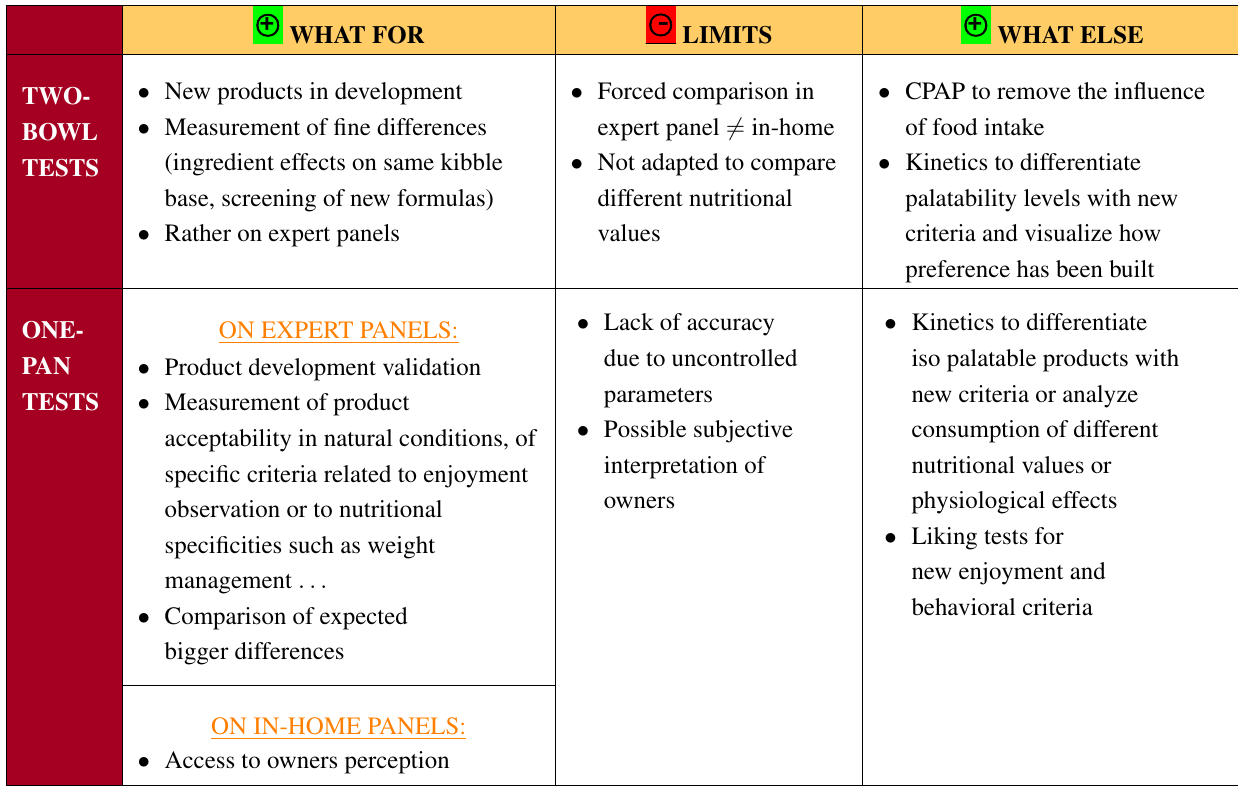
Table 1. Summary of the pros and cons of the different methods. ○ + WHAT FOR ○ - LIMITS